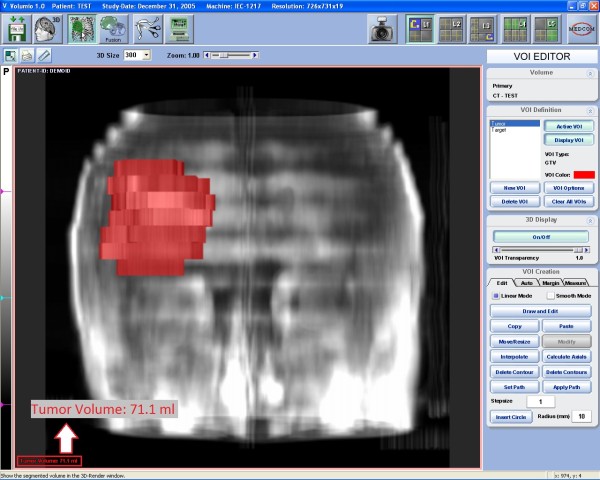
Volumetry. Three-dimensional reconstruction of the volume, based on the regions of interest contoured in Figure 1. The number in the left bottom corner represents the tumor volume in cc.